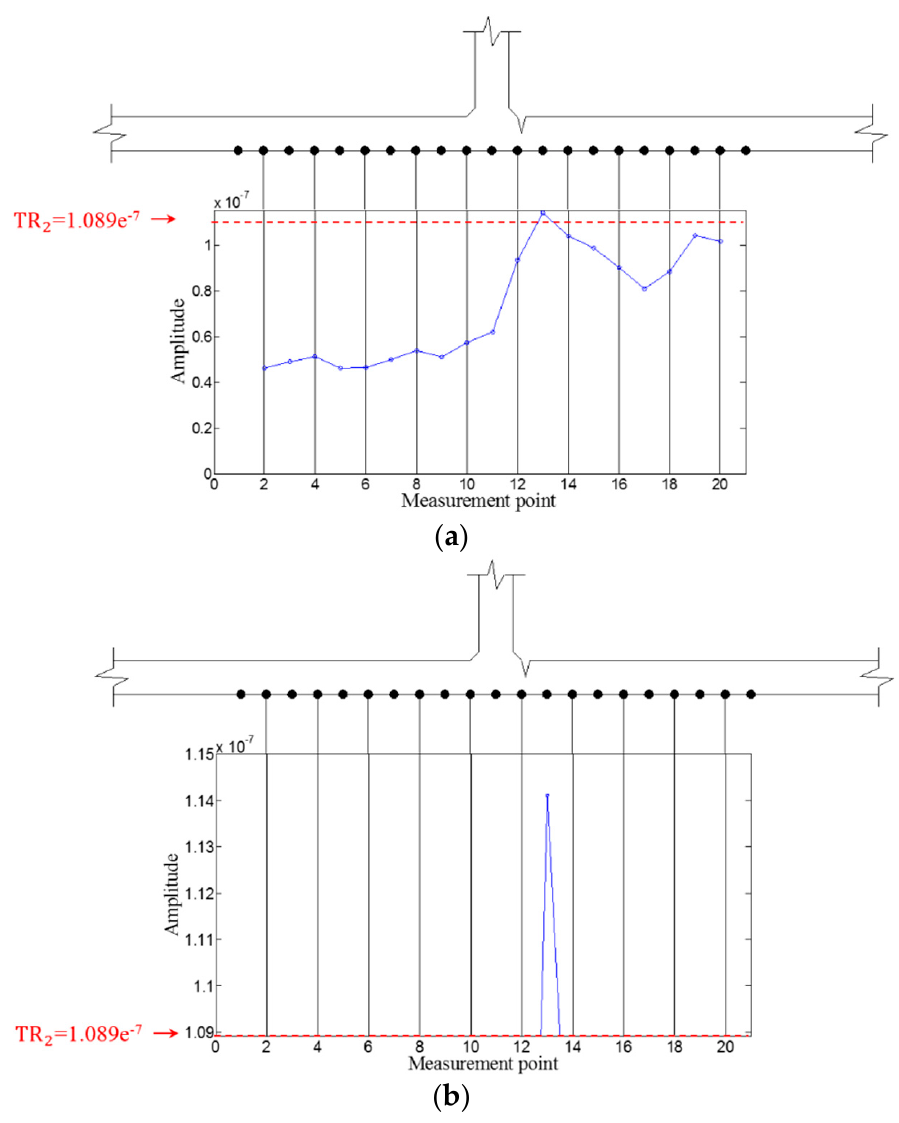
Figure 9. ZLCC values of each measurement node in the crack case at 100 kHz ( a ) before and ( b ) after applying TR 2 .